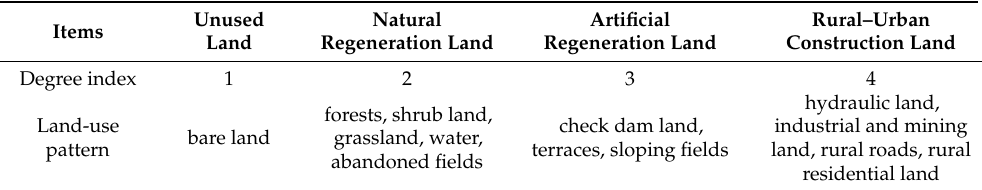
Table 2. The standard of dividing land use degree.